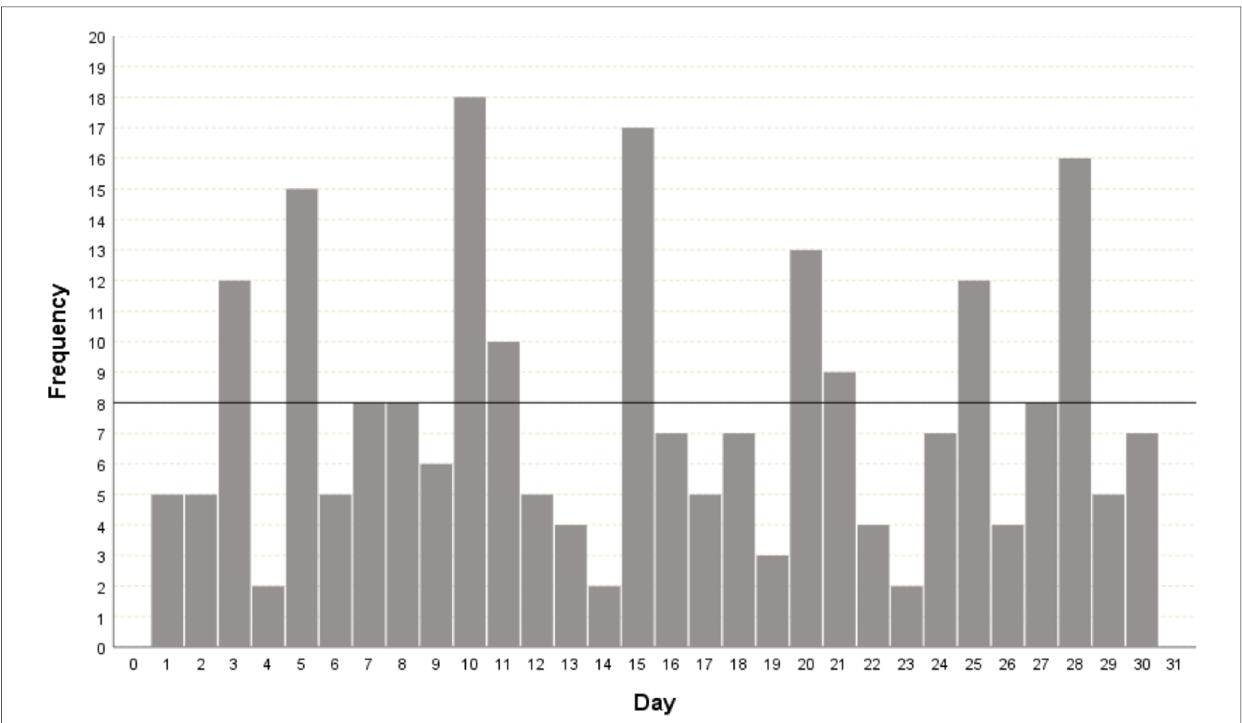
FIGURE 3 Histogram for the day of the month of the date of the last menstrual period as reported by the pregnant woman. The highlighted black line corresponds to the expected frequency of the day of the LMP reported among the 30 days of the month; that is, it is expected that each day of the month will appear eight times.